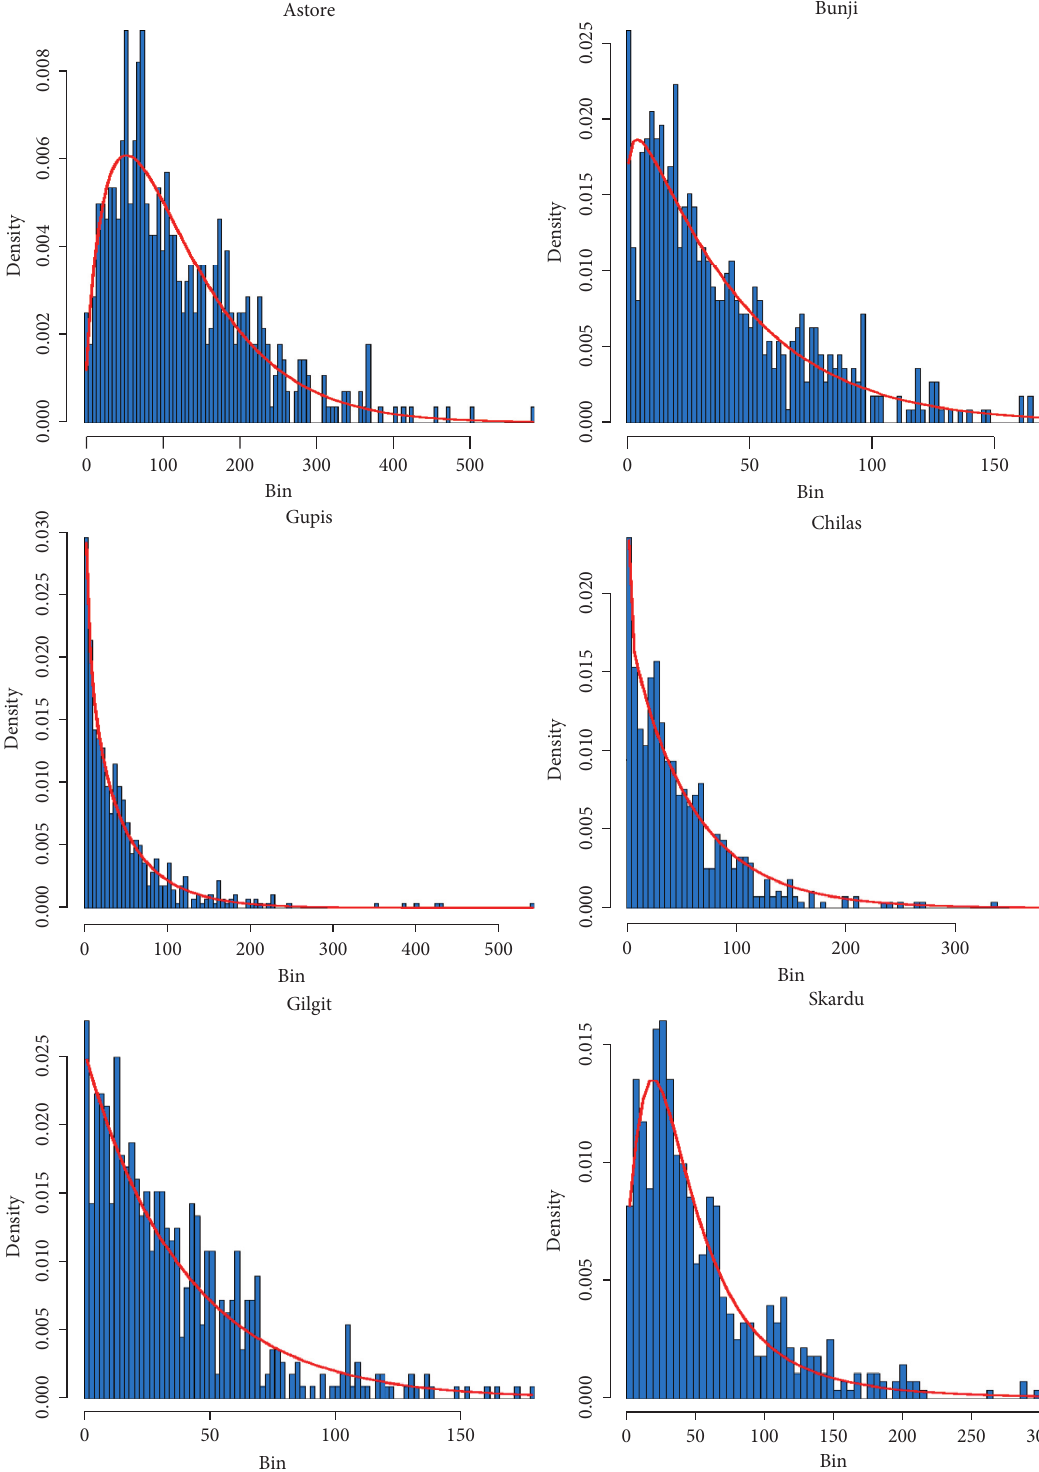
Figure 2: The varying distributions are selected for the six selected stations. The histograms (theoretical vs. empirical) of the selected distributions are presented for